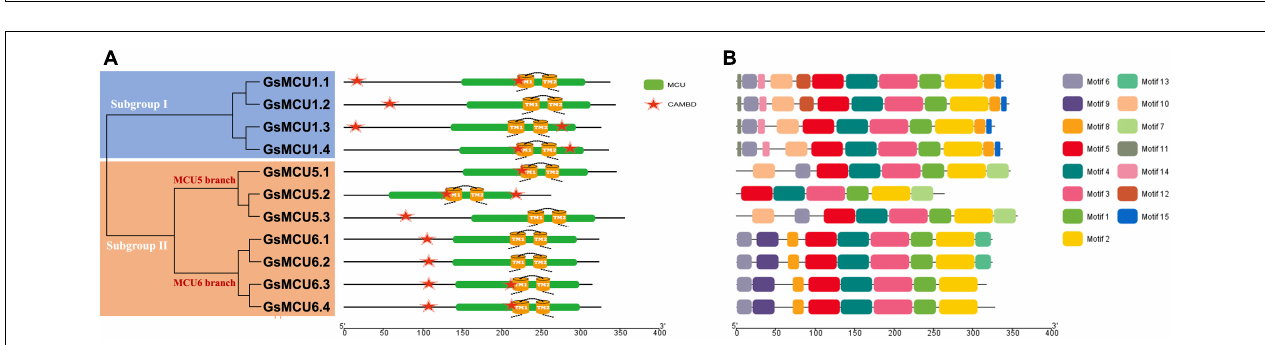
FIGURE 3 | Gene structure analysis of GsMCU family. The position of exons, introns, and untranslated regions (UTRs) are indicated by yellow, black, and blue boxes, respectively. The scale bar at the bottom was used to estimate the sizes of the exons, introns, and untranslated regions.